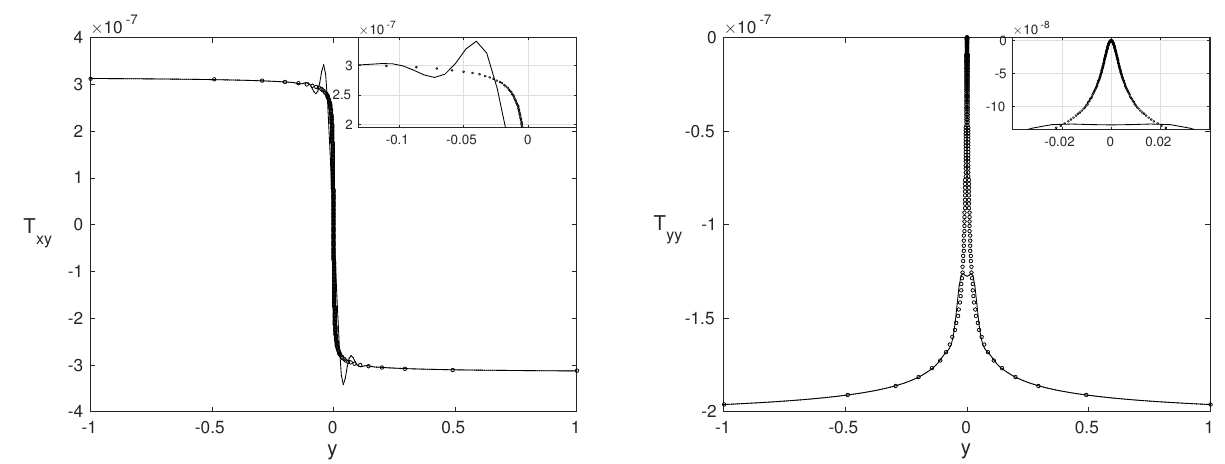
Figure 11. Same as in Figure 1 for dimensionless numbers: Re = 8000, β = 0.5, α G = 0.3 and Wi = 300.